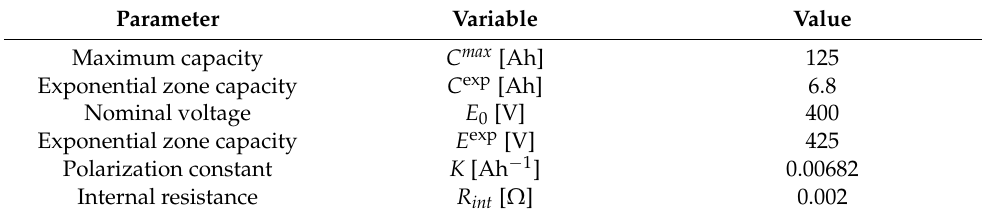
Table 1. Parameters implemented for the considered Li-Ion battery.